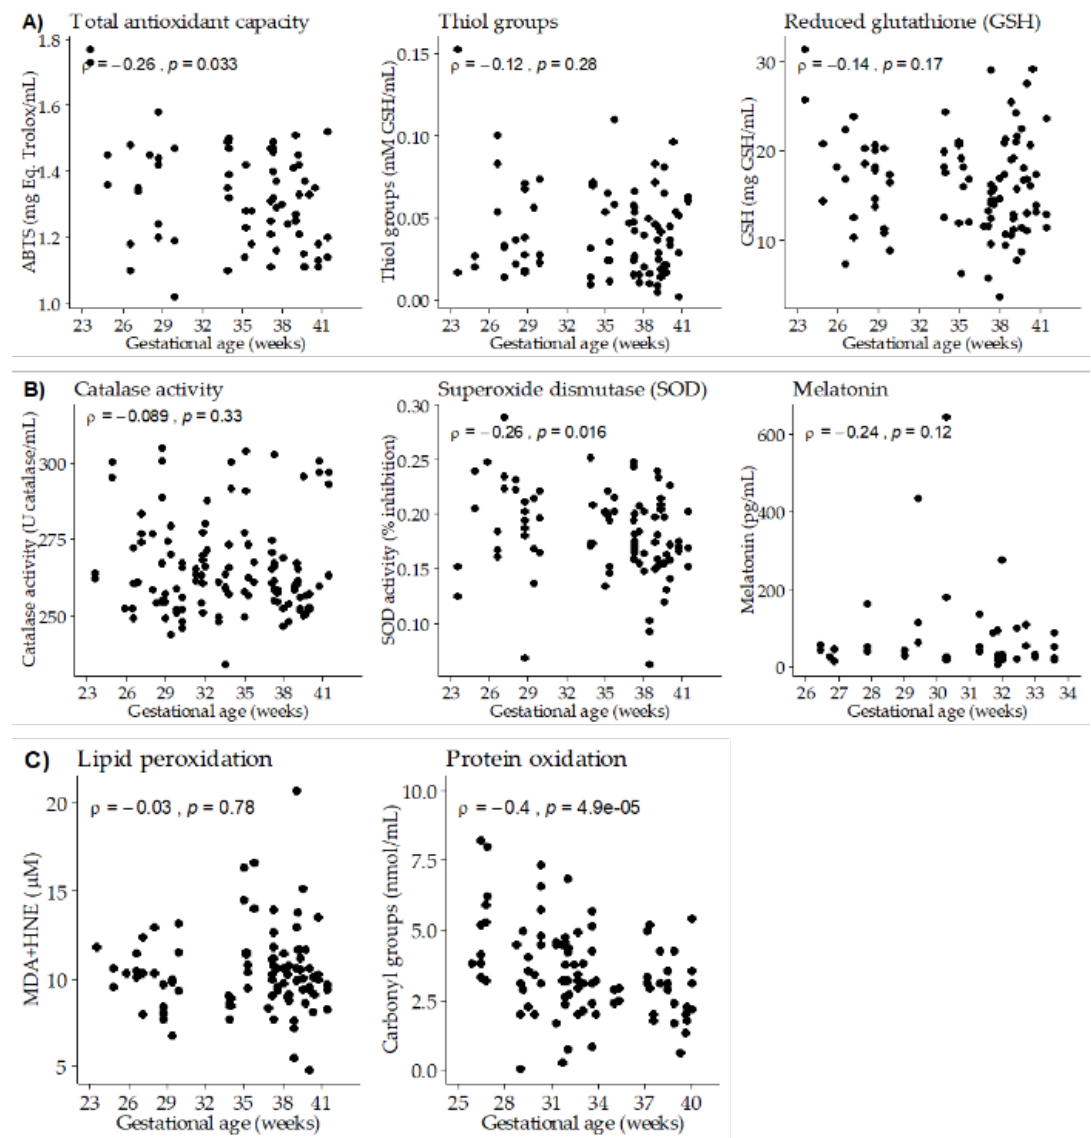
Figure 2. Scatter plots of breast milk antioxidants and oxidative damage biomarkers versus gestational age. ( A ) Total antioxidant capacity and low molecular weight antioxidants. ( B ) Antioxidant enzymes. ( C ) Oxidation biomarkers. Rho – Spearman test ( ρ ) and associated p -values are shown in each plot.